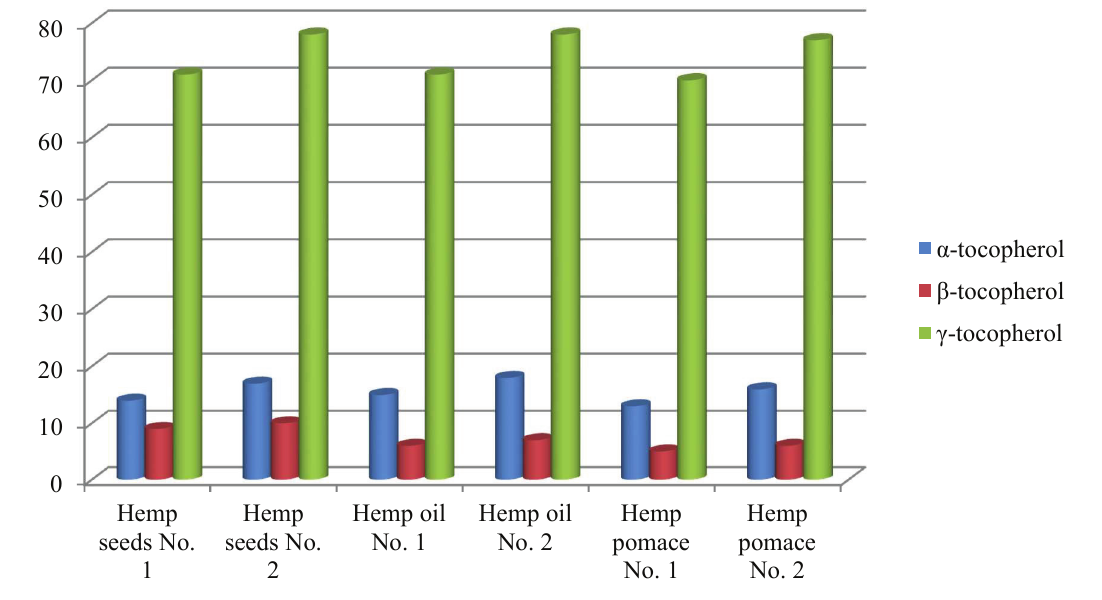
Fig. 3. The content of tocopherols in Cannabis sativa L. raw